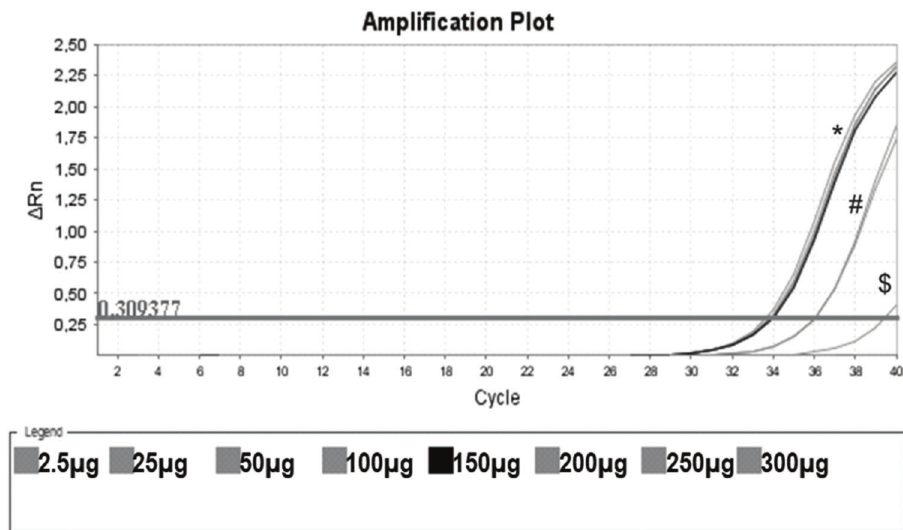
Figure 3 - Protein Titration with One Unstimulated Sample. Protein titration of one unstimulated volunteer sample, initiating on the protein concentration of 0.0025 mg/mL (no amplification), 0.025 mg/mL ($), 0.050 mg/mL, 0.100 mg/mL (#), 0.150 mg/mL (black line) and 0.20 mg/mL, 0.25 mg/mL and 0.30 mg/mL (*). In this assay, CHAPS and ultrapure water were also used as negative controls (no